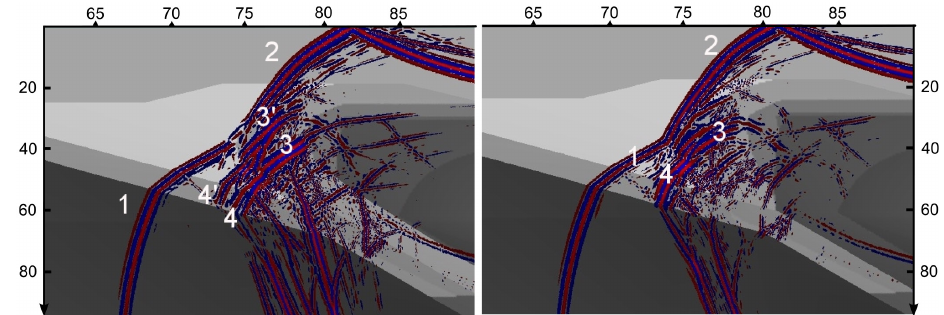
Fig. 7: Snapshot of P wave propagation for a model with DSC (left) and without DSC (right). Propagation time is 18.15 s. Phase 1 is the slab refracted wave, phase 2 the direct P phase and 3 and 4 are guided waves. Note that in the model with DSC there are two guided waves (3, 3 0 and 4, 4’). Phases 4 and 4 0 in the model with DSC are much weaker and phases 3 and 3 0 are much stronger than their counterparts in the model without DSC. Numbering of phases is the same as in Fig. 9. See Fig. 6 for explanation of axis labels and color shading.